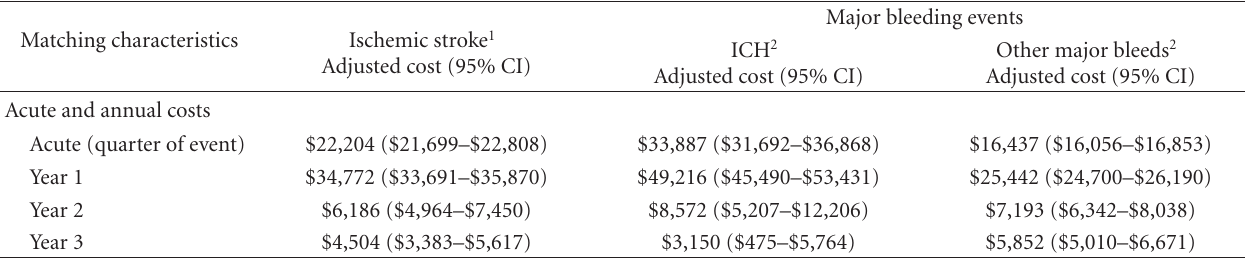
Table 4: Adjusted total incremental cost of ischemic stroke, intracranial hemorrhage, and other major bleeding events (2011 USD). Matching